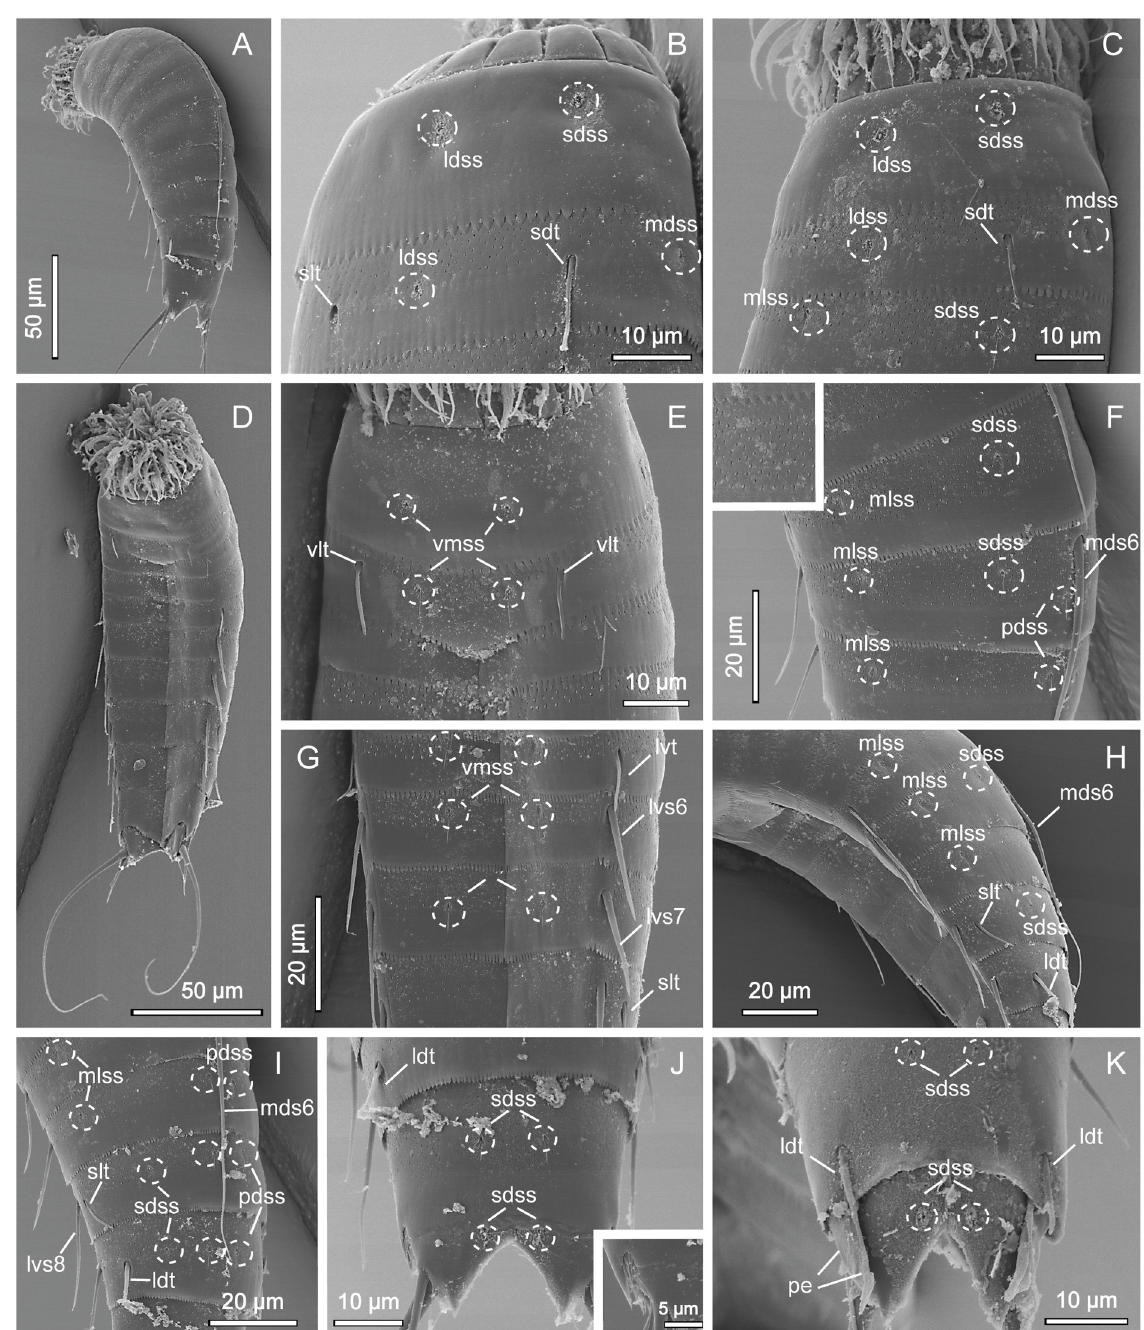
Fig. 10. Scanning electron micrographs showing overviews and details of Echinoderes dalzottoi sp. nov. A . Dorsolateral overview. B . Segments 1 to 2 of specimen with (broken) sublateral tube on segment 2, dorsolateral view. C . Segments 1 to 3 of specimen without sublateral tube on segment 2, dorsolateral view. D . Ventral overview. E . Segments 1 to 3, ventral view. F . Segments 4 to 7, dorsolateral view with inset showing close-up of cuticular hairs that are reduced to minute scales. G . Segments 5 to 8, ventral view. H . Segments 5 to 9, lateroventral view. I . Segments 6 to 9, dorsolateral view. J . Segments 10 to 11 of female, dorsal view with inset showing close-up of midlateral fringe-like structure on segment 10. K . Segments 10 to 11 of male, dorsal view. Abbreviations: see Material